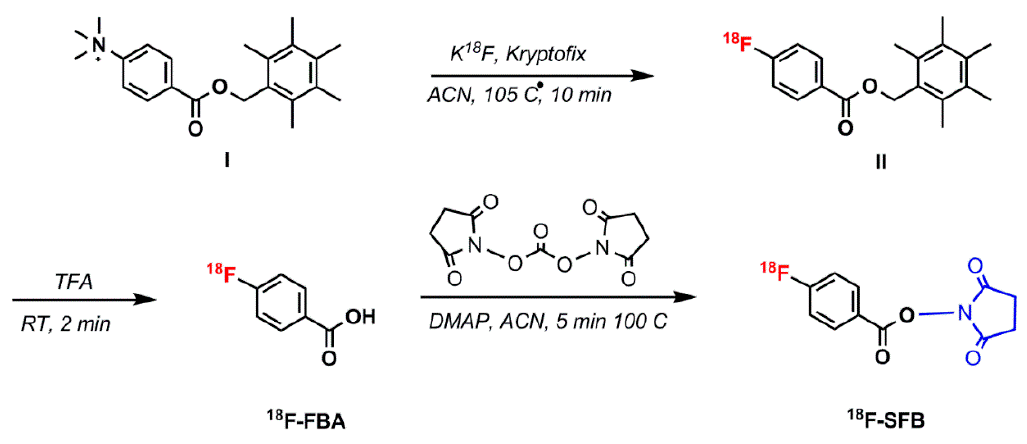
Figure 12. The 3 step synthesis of 2,5-dioxopyrrolidin–1-yl 4-(fluoro– 18 F)benzoate ( 18 F–SFB).